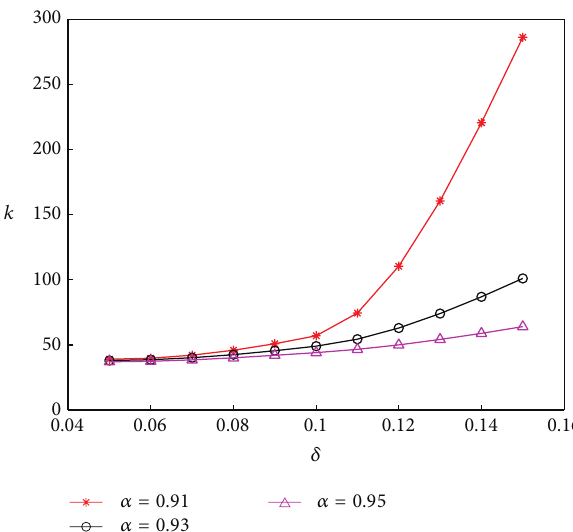
Figure 6: Correlation between 𝑘 and 𝛿 with given different 𝛼